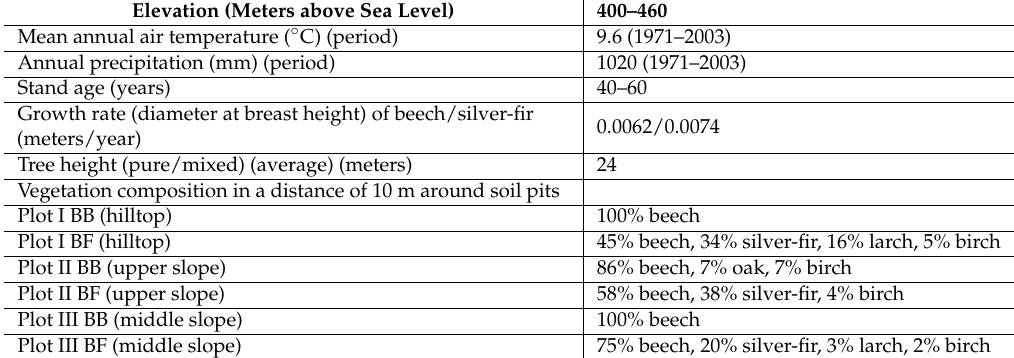
Table A1. The stand characteristics of the stand in the Black Forest,